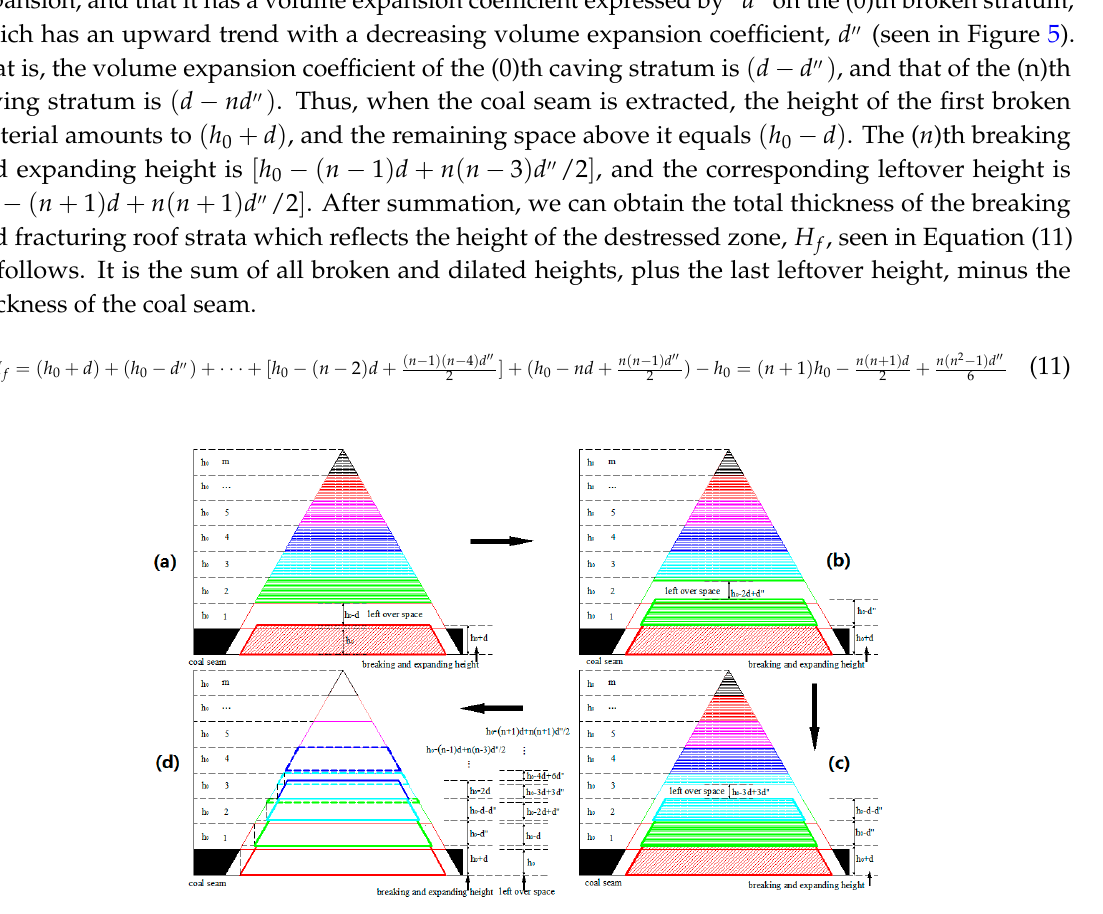
Figure 5. Schematic cross-sectional drawing of the trapezoidal broken model showing the sequential caving of model III: ( a ) after the (0)th layer failure of the roof stratum due to coal extraction, ( b ) after (1)th layer failure of the roof stratum, ( c ) after (2)th layer failure of the roof stratum, ( d ) after the ( n − 1)th layer failure of the roof stratum.